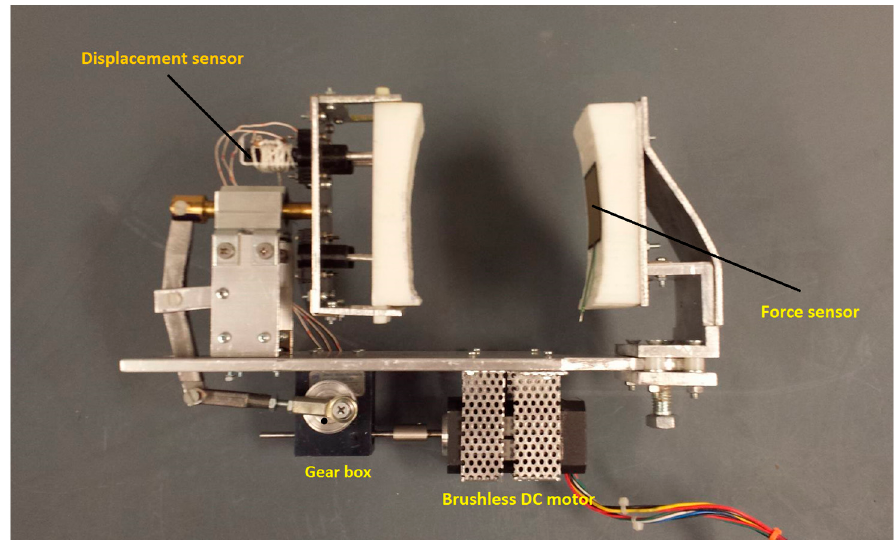
Figure 12. Experimental setup illustrating all the parts of the device.